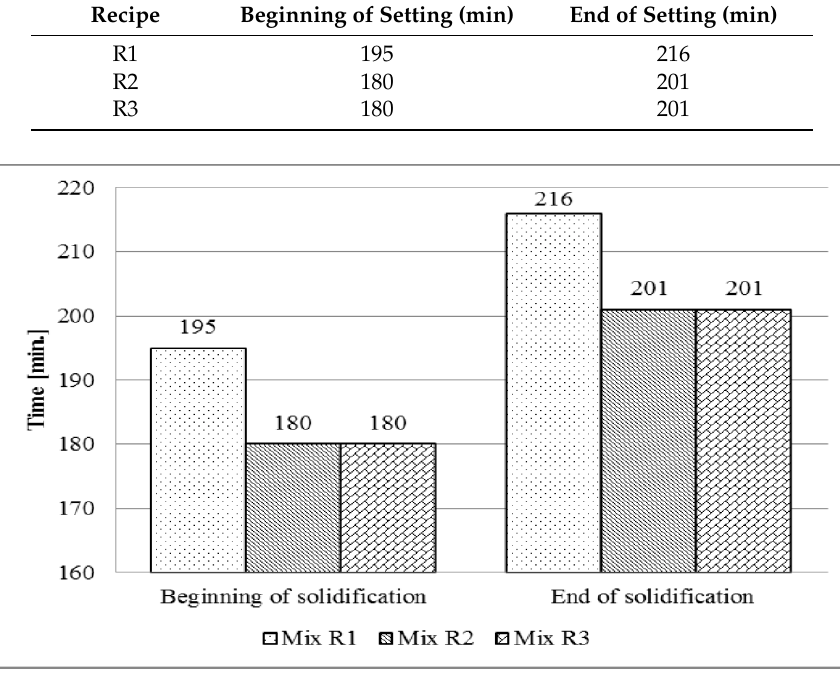
Figure 2. Chart of the measurement of the beginning and end of setting of R1, R2 and R3 mixtures.